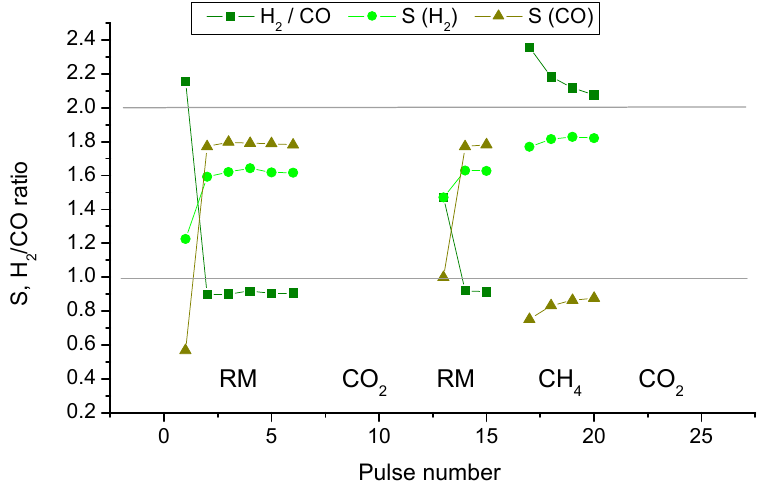
Figure 5. Product selectivities and syngas composition in series of pulses at 773 K.